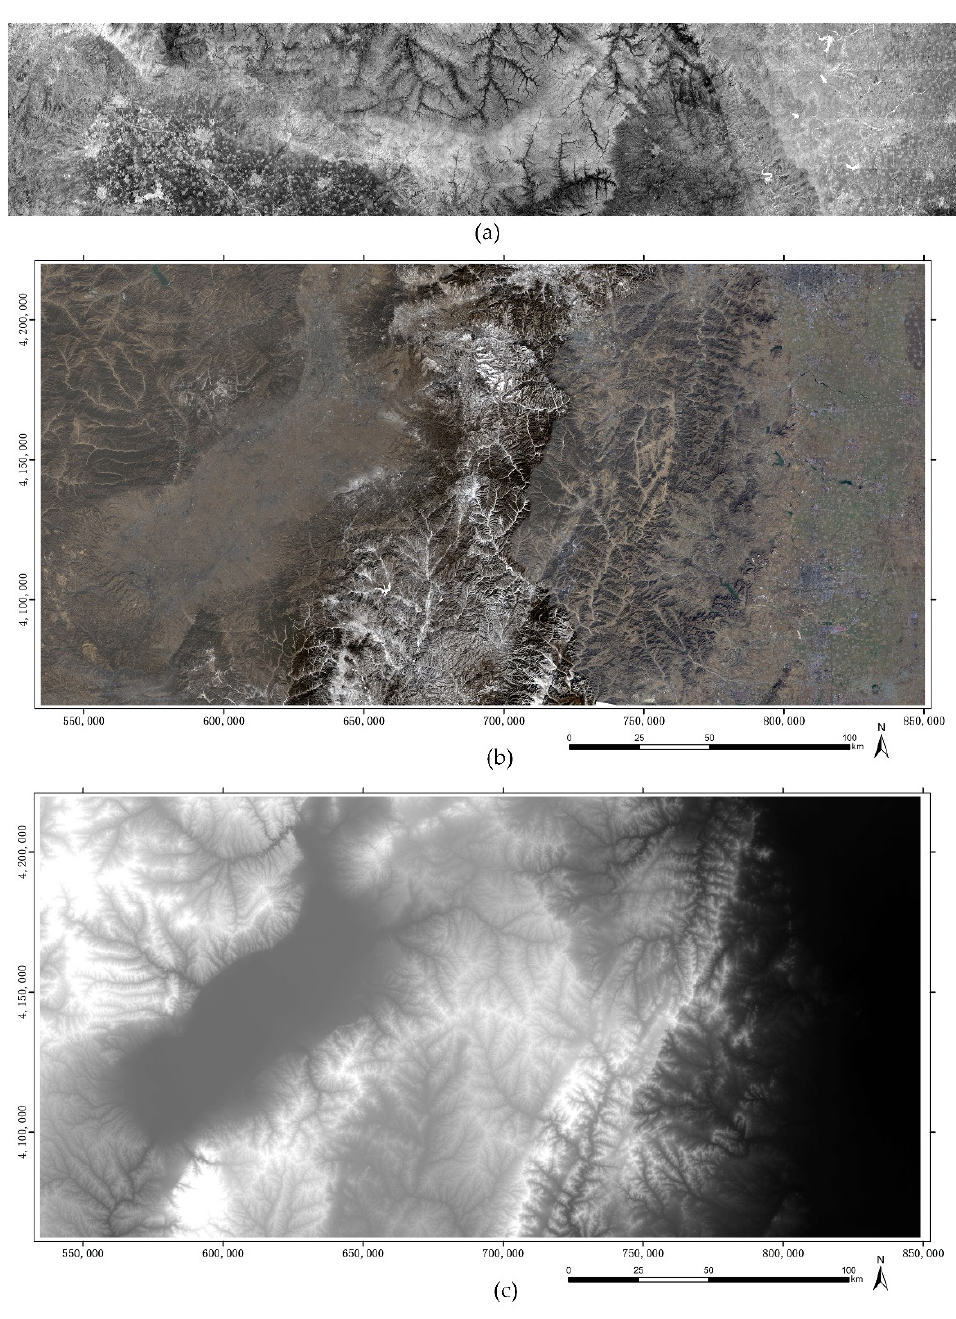
Figure 5. Test data for orthorectification. ( a ) SDGSAT-1 L1A TIR image (in order to display clearly, the TIR images have been processed by homomorphic filtering.); ( b ) reference image (Landsat-8 true color synthesis orthoimage, UTM 49 N); ( c ) STRM DEM image (UTM 49 N).